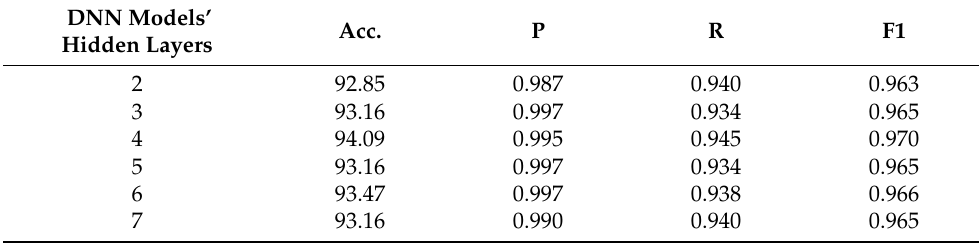
Table 2. Bee activity acoustic classification results with deep neural network acoustic